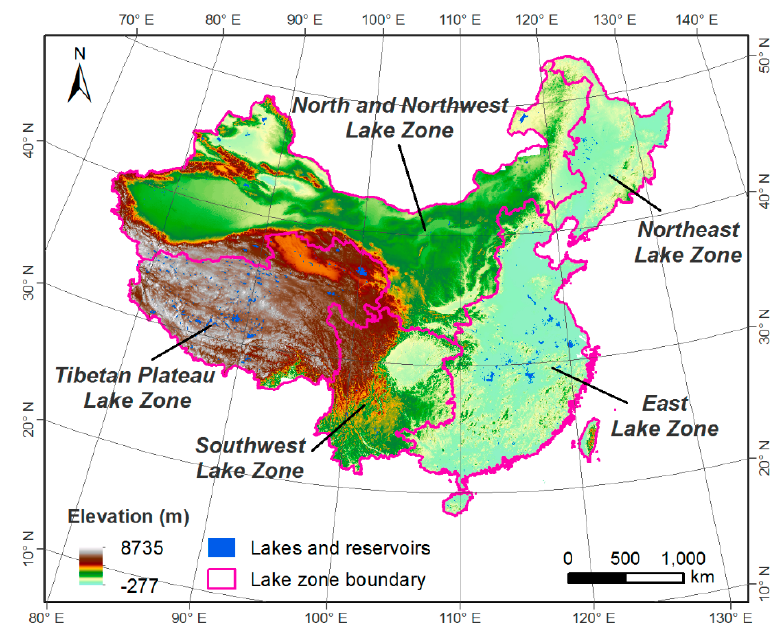
Figure 2. The reference boundaries for 829 lakes and reservoirs and 5 lake zones in mainland China. The division of the lakes zones was based on Ma [27] and renamed here, including (1) the Northeast Lake Zone (NELZ), (2) the North and Northwest Lake Zone (NNWLZ), (3) the East Lake Zone (ELZ), (4) the Southwest Lake Zone (SWLZ), and (5) the Tibetan Plateau Lake Zone (TPLZ).